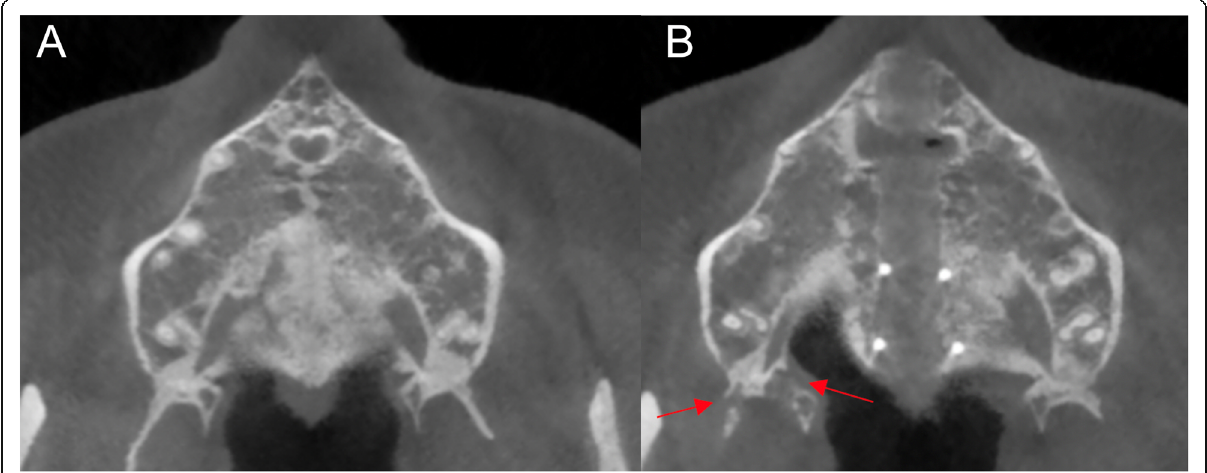
Fig. 9 a Pre-expansion view on axial palatal section. b Post-expansion view on axial palatal section showing the split in medial and lateral pterygoid plates on right pterygopalatine suture